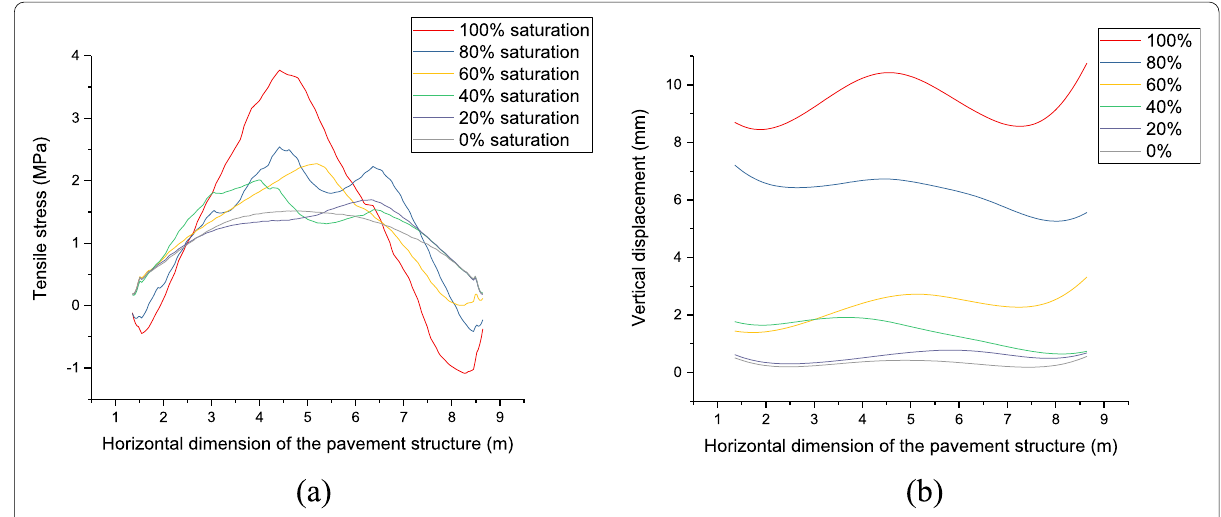
Fig. 13 a The tensile stress and b the vertical displacement on the surface of asphalt layer with different degrees of saturation in the subgrade